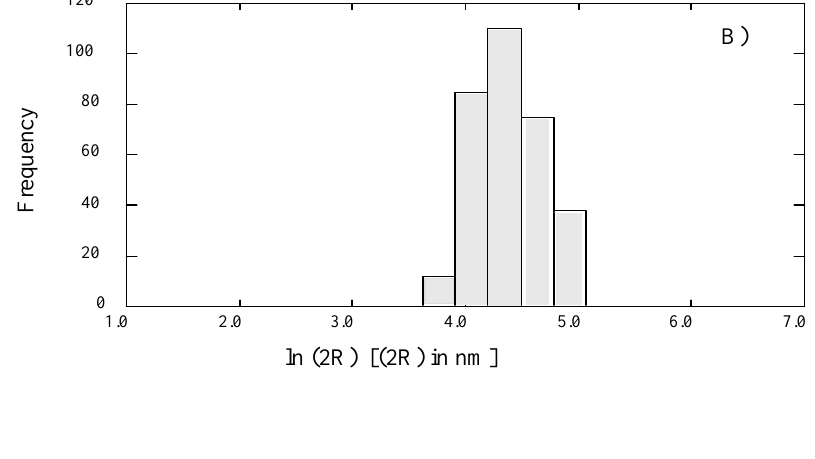
Figure 2. CONTIN analysis of the autocorrelation function for the sample of POPC LUVs: a monomodal distribution with an average hydrodynamic diameter of 145 ± 6 nm is